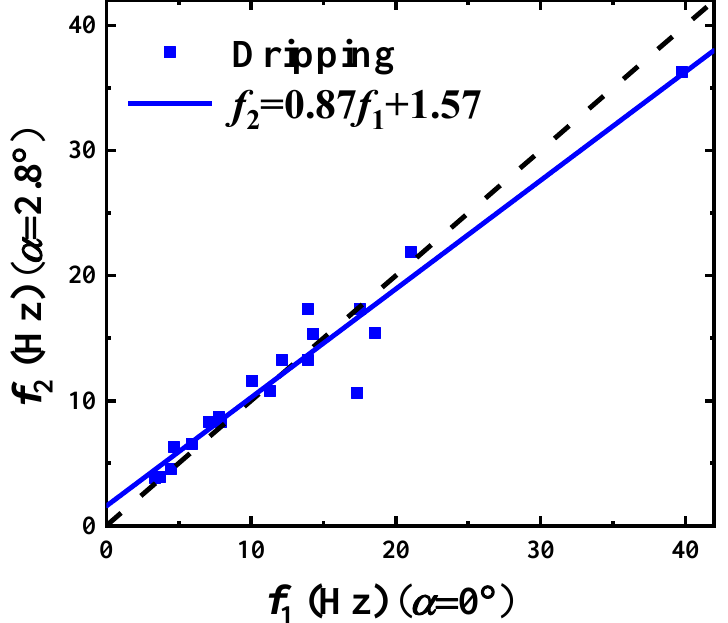
for α = 0 ◦ and d 2 for α = 2.8 ◦ . D d D d